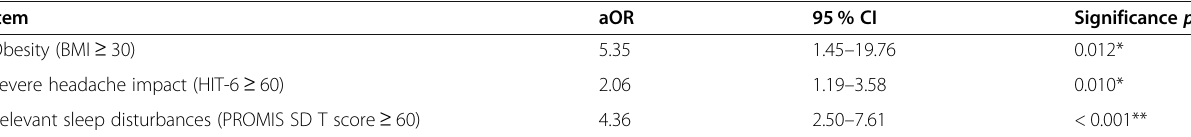
Table 2 Multivariable logistic regression analysis of independent predictors of depression defined as MDI > 20, adjusted for age and sex